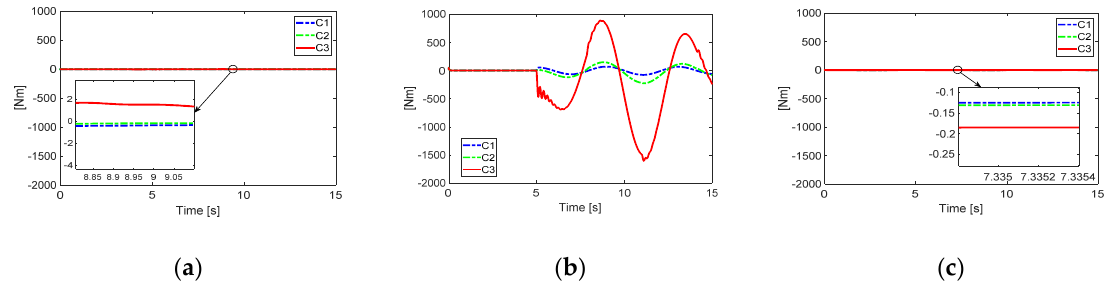
Figure 5. Estimated fault with the different values of ρ 2 ( t ) . ( a ) Joint 1; ( b ) Joint 2; ( c ) Joint 3.